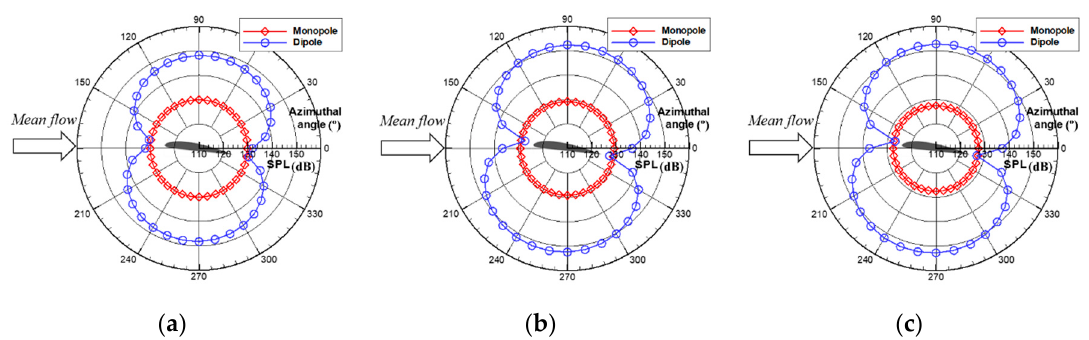
Figure 18. Predicted directivity of radiated hydro-acoustic noise: ( a ) viscous lagging; ( b ) fill viscous; and ( c ) thin-layer cases. Appl. Sci. 2018 , 8 , x FOR PEER REVIEW 24 of 27